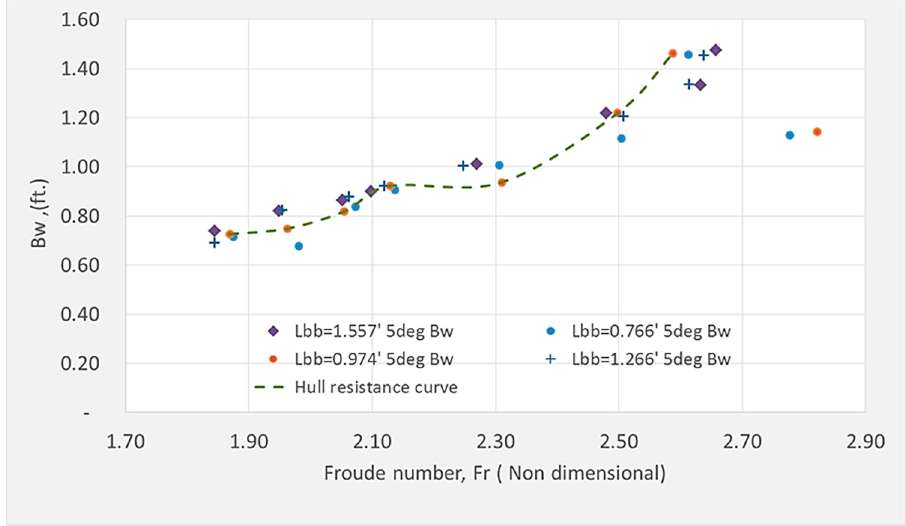
Figure 17. B w for 5° pitch angle.